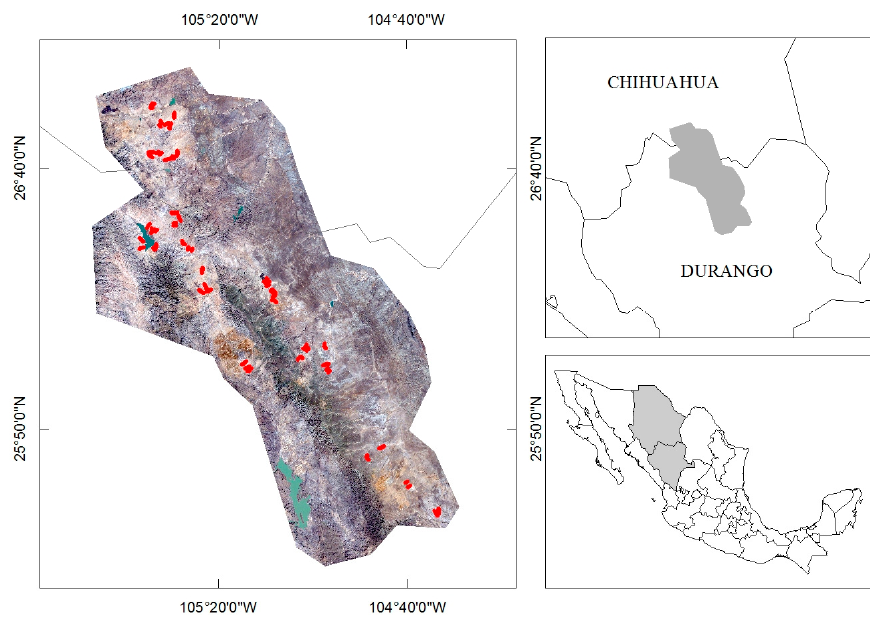
Figure 1. Study area. Sampling sites are marked in red.